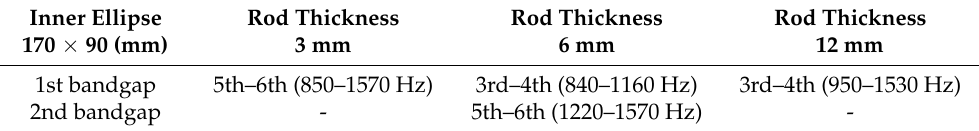
Table 6. Parametric investigation. Inner ellipse 170 × 90.